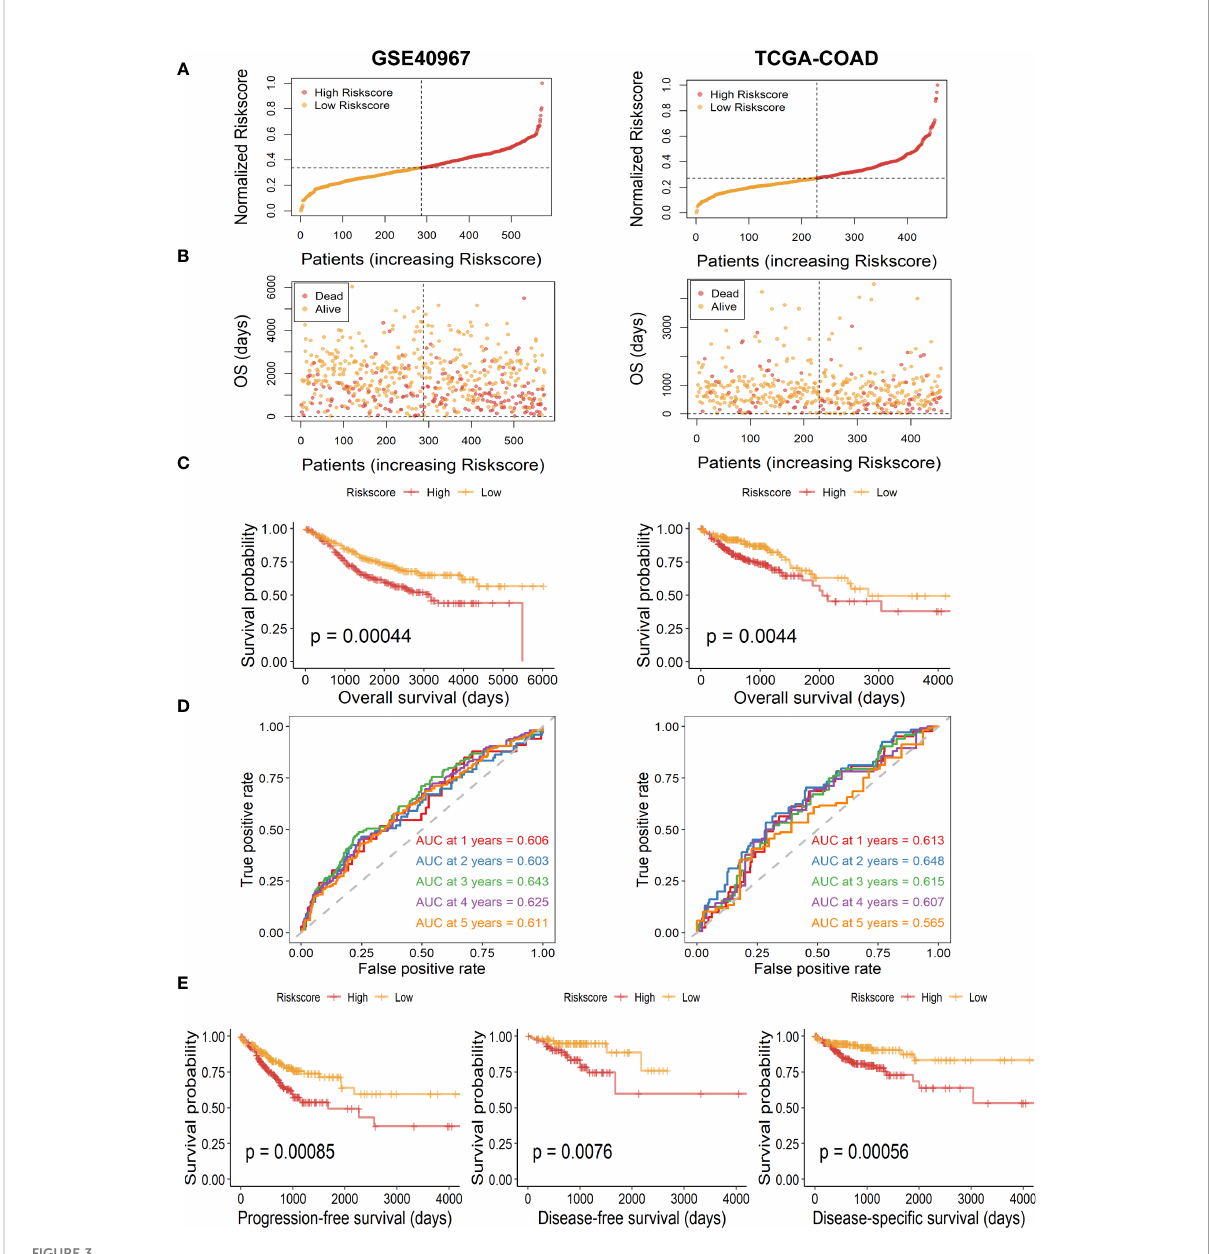
FIGURE 3 Assessment and validation of the availability of risk score in GSE40967 and TCGA-COAD sets. (A) Risk score distribution of COAD samples with different risks. (B) The distribution of risk score and OS time of COAD patients. (C) The Kaplan – Meier survival curves of OS according to high- and low-risk groups in patients with COAD. (D) The time-dependent ROC curves and AUC values for OS of the prognostic risk model. (E) The Kaplan – Meier survival curves of PFS, DFS, and DSS according to different risk